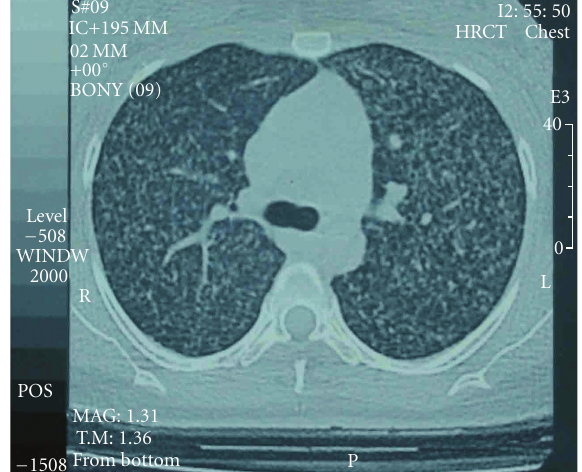
Figure 2: HRCT chest-lung window: bilateral di ff use miliary nod- ular opacities showing random